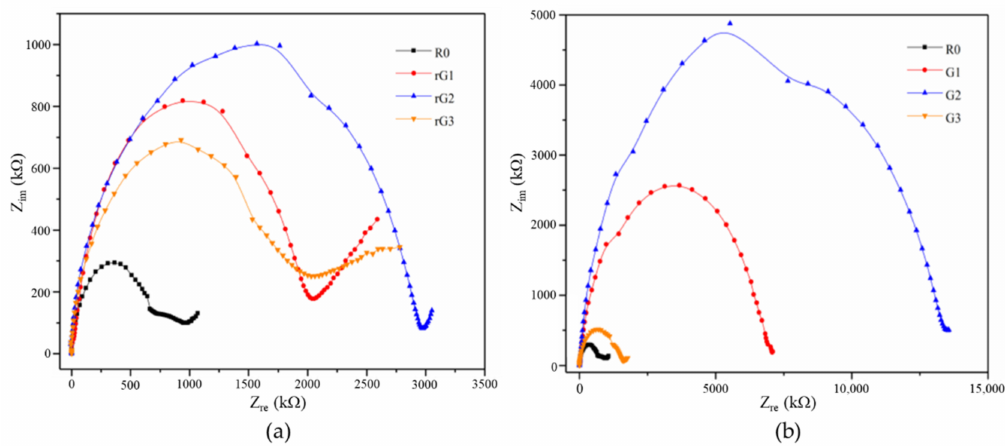
Figure 15. Nyquist curves of the samples with rGO ( a ) and GO ( b )